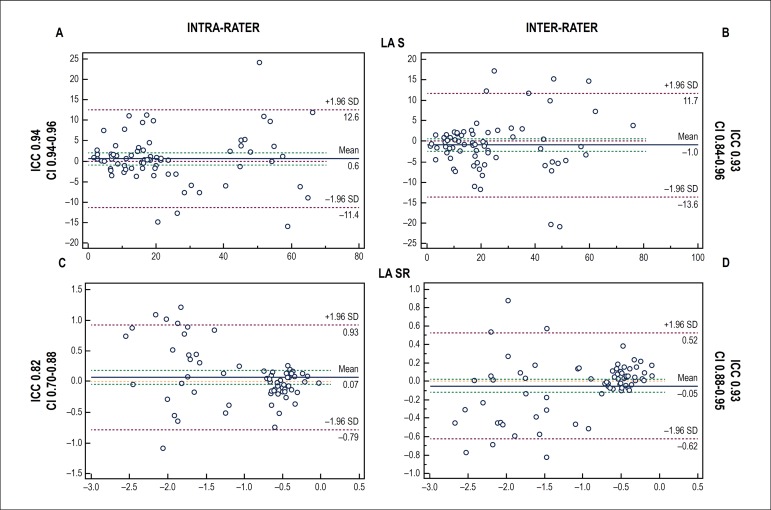
Intraclass correlation coefficient calculated (ICC) and Bland Altman
difference plot combined with calculation of 95% limits of agreement
(CI) of the intra-rater (A,C) and inter-rater (B,D) agreement of LA
strain (LA S) and LA strain rate (LA SR)